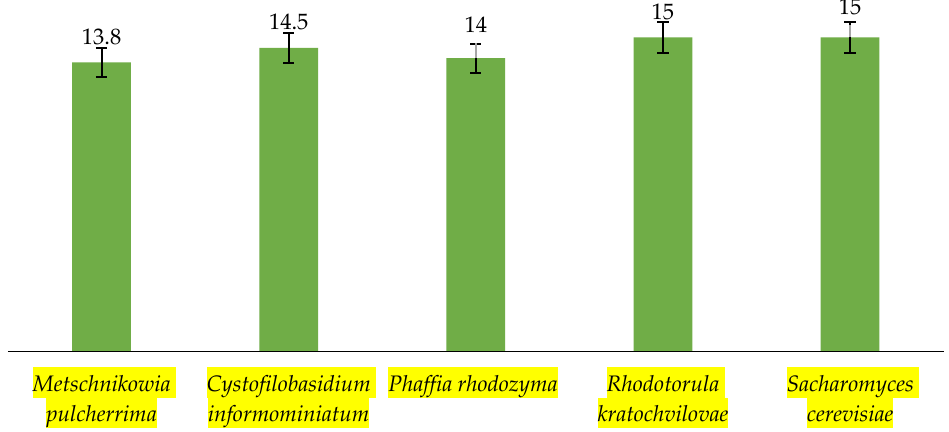
Figure 1. Biomass yield (g/L) after cultivation in Erlenmeyer flasks after 96 h.